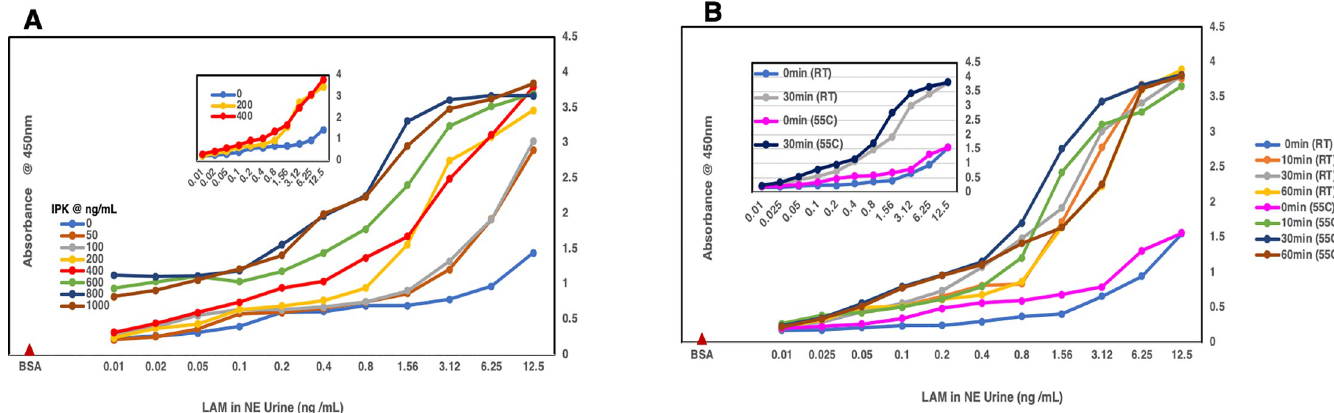
Fig 5. Capture ELISA. A) Graph plot showing the concentration curve (0–1000 μ g / mL) for IPK pretreatment of NEU spiked with LAM. Optimal results are obtained at 400 μ g / mL concentration of IPK as compared to 0 μ g /mL (see inset). B) Shows the optimal time and temperature required to obtain the best results in a capture ELISA when using IPK for pretreatment of urine spiked with LAM. The graph shows no significant difference between the various time points and temperatures variations, hence the optimal conditions for C-ELISA taken with IPK is 400 μ g / mL for 30 min at room temperature.